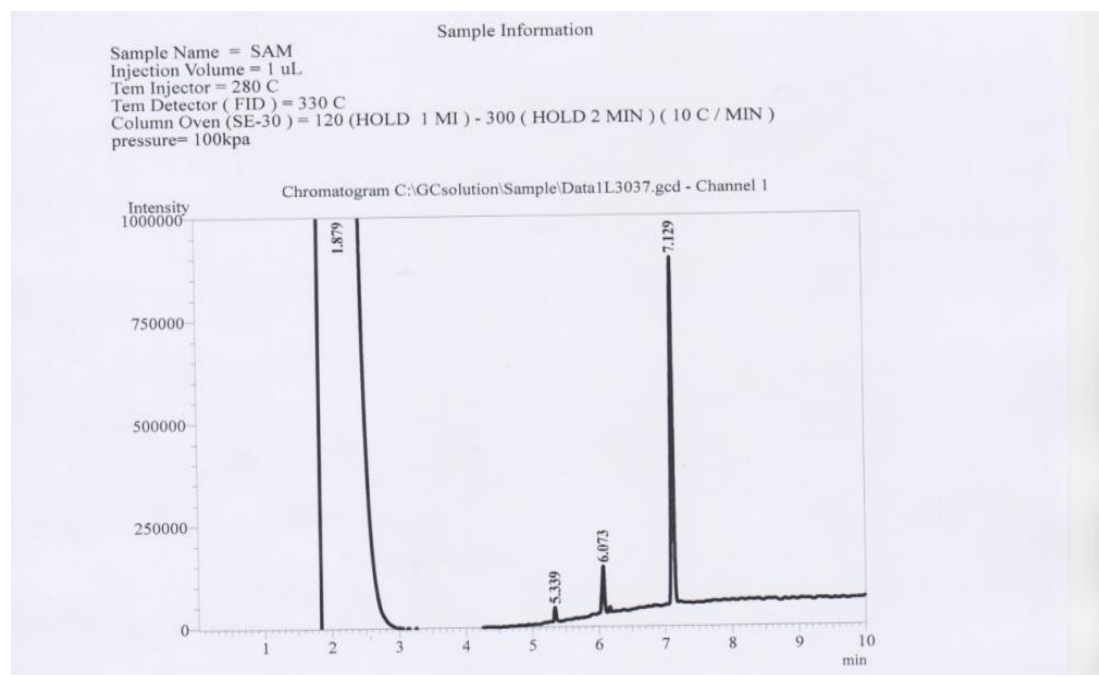
Figure 11. HPLC chromatogram of lyophilized powder for mirtazapine in the selected formula, f15